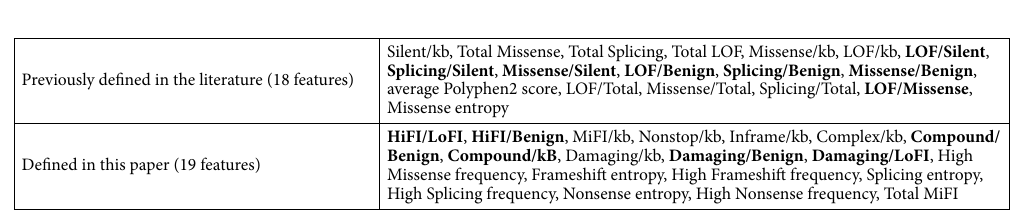
Defined in this paper (19